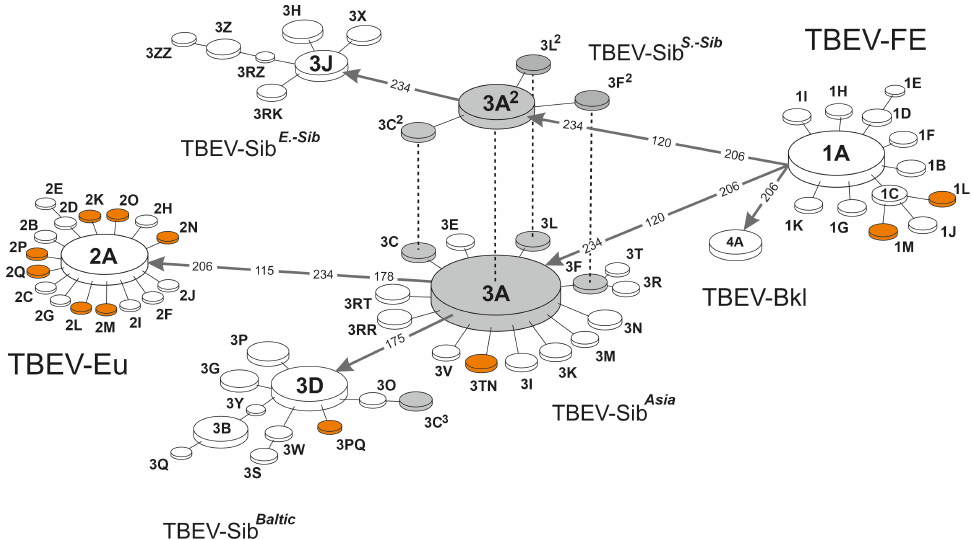
Figure 2. Updated version of the clusteron structure. The platform recently identified eleven new clusterons, which are highlighted in orange. Homoplastic clusterons are connected together by dotted